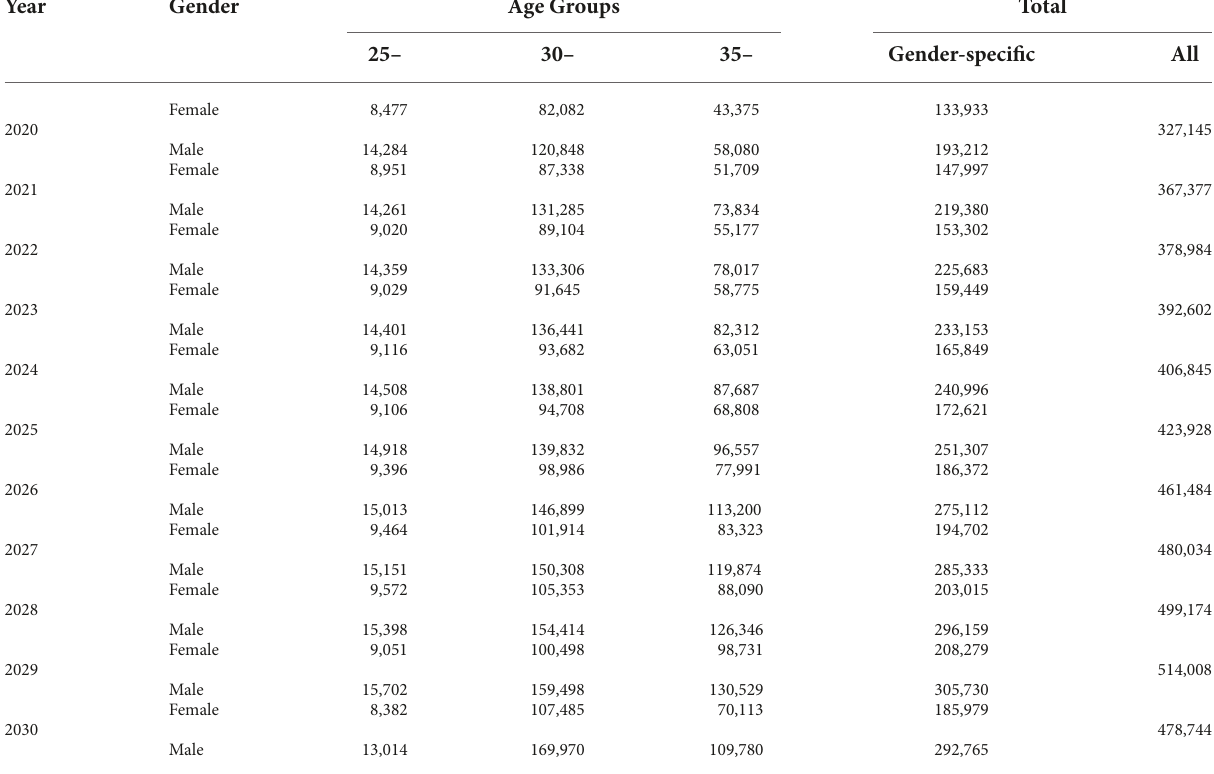
TABLE 2 Projected age-specific number of PD patients in China by gender from 2020 to 2030 based on the BAPC framework a